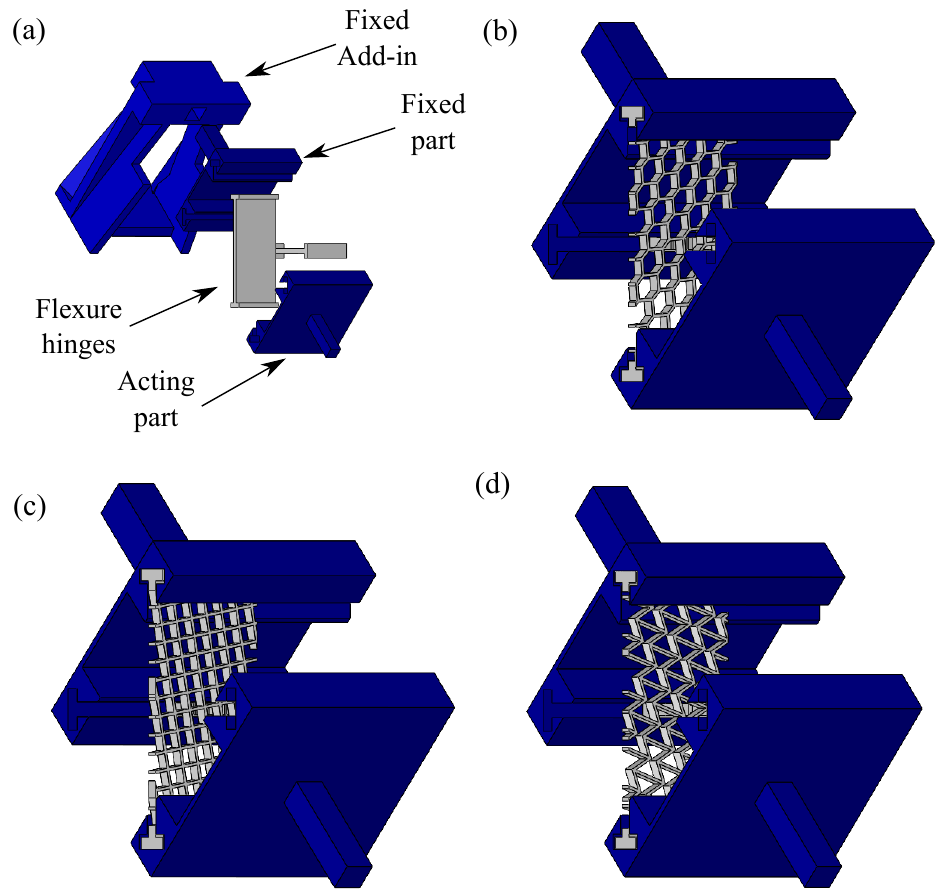
Figure 4. Principal components and lattice-flexure hinges with different configurations used for the compliant cross-axis joints. ( a ) Isometric exploded view of the compliant cross-axis joint with its fixed add-in. ( b ) Compliant cross-axis joint with hexagonal lattice-flexure hinges with a unit cell dimension of 3.5 mm and an orientation of 40°. ( c ) Compliant cross-axis joint with square lattice-flexure hinges with a unit cell dimension of 2.5 mm and an orientation of 80°. ( d ) Compliant cross-axis joint with re-entrant lattice-flexure hinges with a unit cell dimension of 5.5 mm and an orientation of